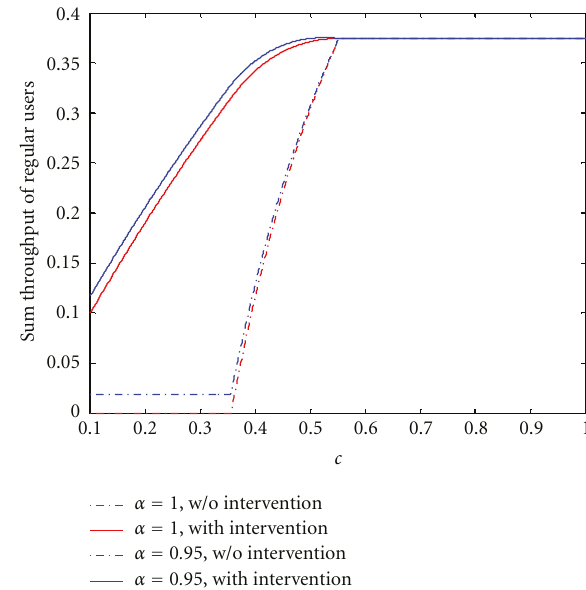
Figure 7: Sum throughput of all the regular users under “imper- fect” jammer.